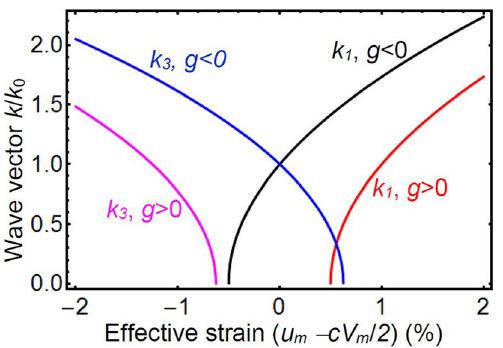
Figure 2. The dependence of the wave-vector component k 1 / k 0 and k 3 / k 0 on the effective strain ( u m − cV m / 2 ) calculated from Eq. (11) for g > 0 (red and magenta curves) and g < 0 (black and blue curves), parameters b 1 = 200 and b 3 = − 160